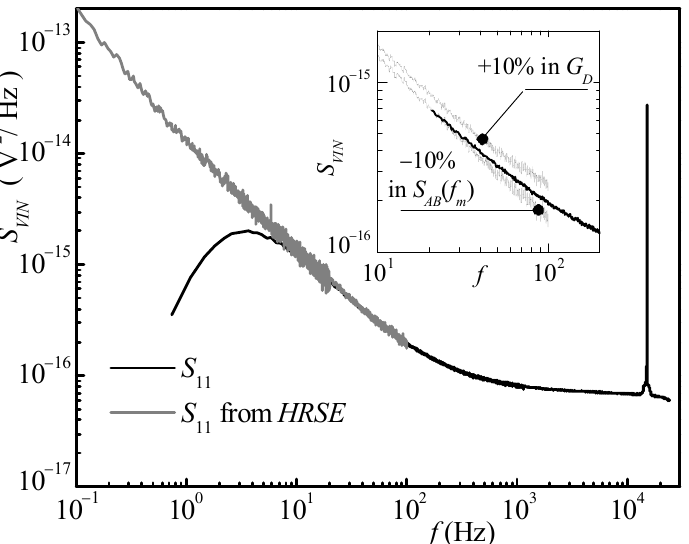
Figure 6. Result of noise measurements with the switch S W in Figure 5 is closed. The equivalent input noise S VIN is obtained by dividing the output noise by the amplifier gain squared. The black curve is obtained from conventional spectral estimation. The gray portion of the curve is obtained from the NBSE mode in QLSA using Equation (2). The inset shows when the incorrect values for the parameters S AB ( f m ) and G D in Equation (2) are chosen.